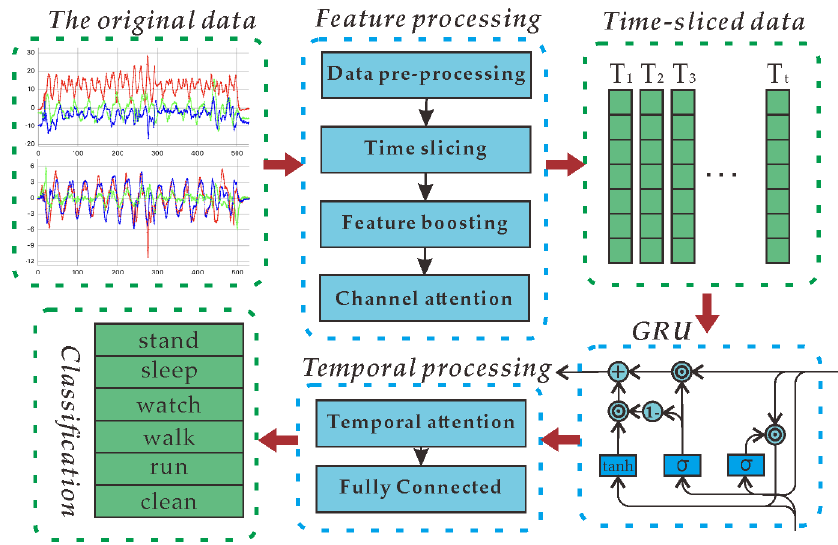
Figure 1. Framework of the proposed approach.